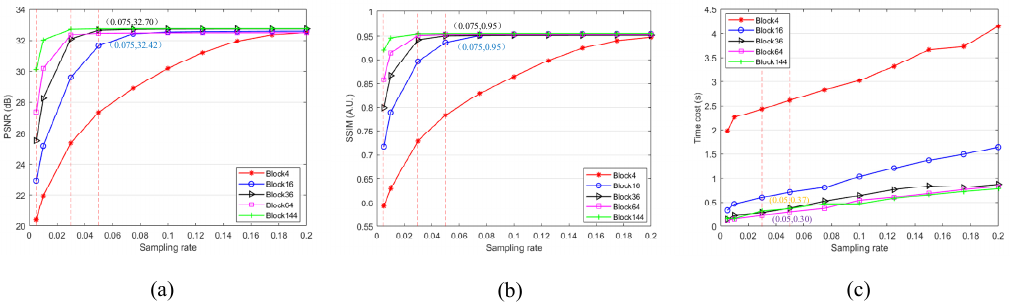
Figure 8. Quantitative analysis results of ‘PRGI’ under the condition of different image sizes and different block numbers. ( a ) PSNR; ( b ) SSIM; ( c ) Time cost.